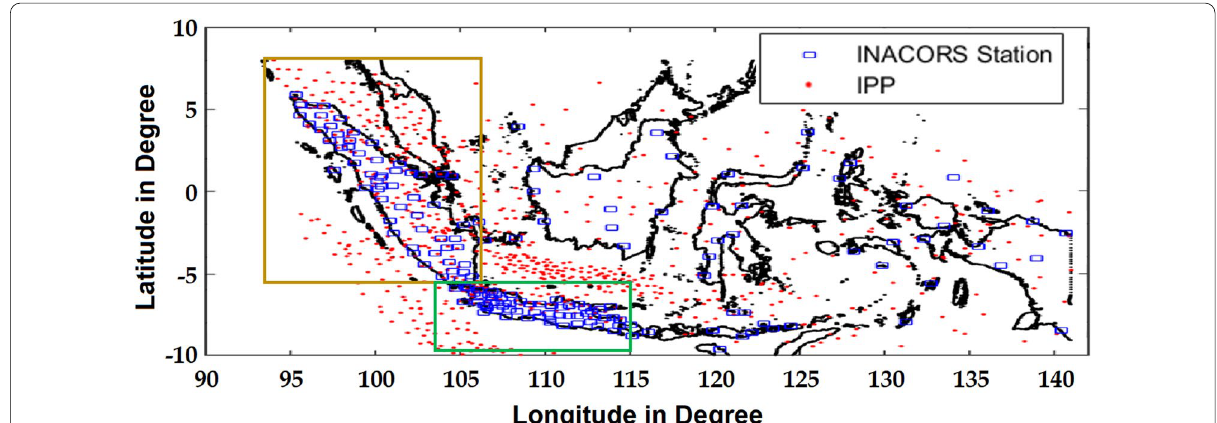
Fig. 2 Distribution of CORS station (blue) and their IPP (red) on January 1, 2019, for spatial analysis. Analysis of the Northwest–Southeast region using CORS data in Sumatra and Java